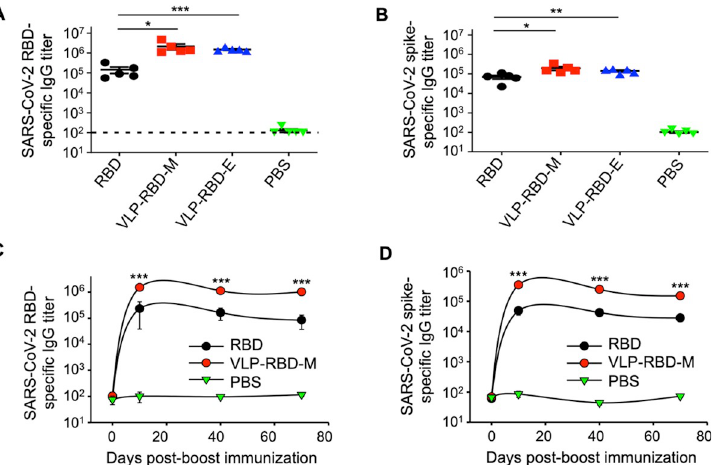
Fig 2. VLP-RBD vaccine induces high-titer antibody responses in mice. Mice were immunized with RBD, VLP-RBD-M (VLP was prepared from mammalian cells), VLP-RBD-E (VLP was prepared from bacterial cells), or PBS. Mouse sera were collected on day 10 post-2 nd immunization for detection of RBD-specific antibodies (A) and spike-specific IgG antibodies (B) using ELISA. Mouse sera were also collected on later dates for detection of RBD- specific antibodies (C) and spike-specific IgG antibodies (D). For ELISA, plates were pre-coated with recombinant SARS-CoV-2 RBD or spike ectodomain, and antibody titers were reported as the highest serum dilution that remained detectable (defined as signal being at least twice of the blank). The dotted line indicates the detection limit (defined as the lowest serum dilution when signal was still below detectable levels). The data are presented as mean ± SEM (n =